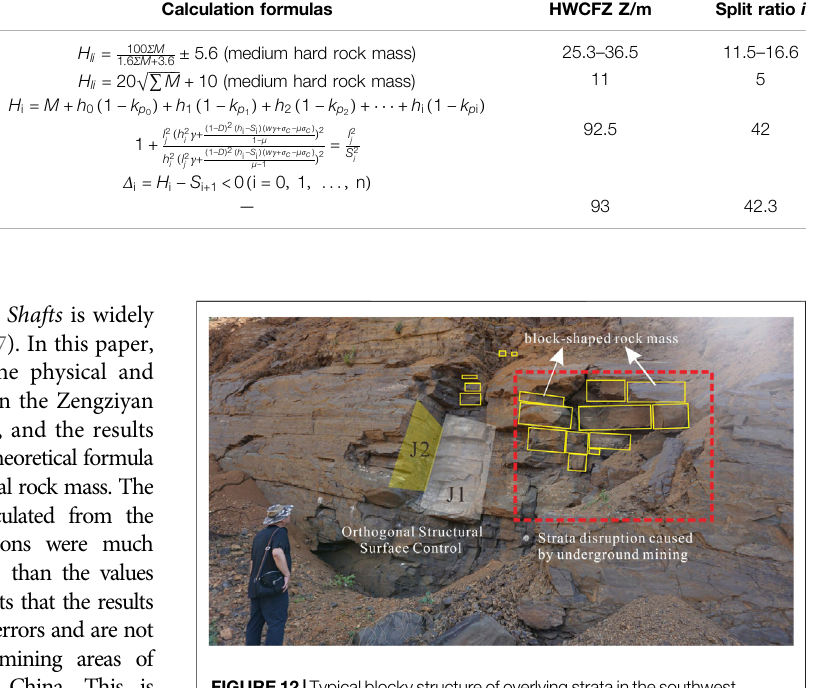
FIGURE12| Typicalblockystructureofoverlyingstratainthesouthwest carbonate mountainous